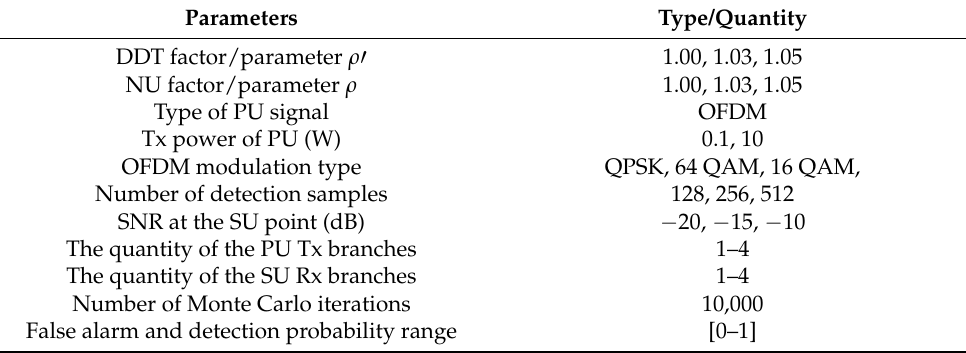
Table 2. Parameters utilized in the simulation of the ED